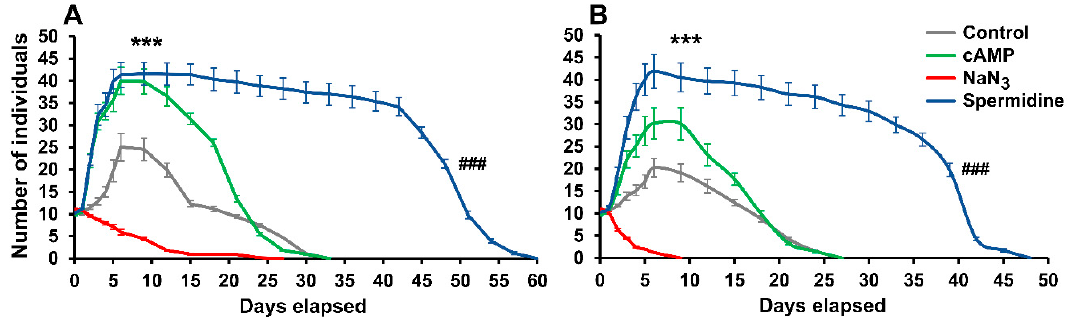
Figure 4. Survival kinetics of rotifer populations treated (100 µ M) with stimulator, toxin or calorie restriction mimetic. The number and survival of individuals significantly increased under spermidine treatment, compared to untreated controls. The cyclic adenosine monophosphate (cAMP) had a positive e ff ect on the reproduction of individuals; however, it had no pronounced influence on the survival of animals. NaN 3 was toxic to both Philodina acuticornis ( A ) and Adineta vaga ( B ) species. The two di ff erent rotifer genera show similar kinetics under the same treatments. The error bars represent SEM. One-way ANOVA with Bonferroni post hoc test was used for statistical analysis, the level of significance is ***; ### p < 0.001 (*, significant di ff erence in number of rotifers from untreated controls on day nine; # significant difference from untreated controls in survival of